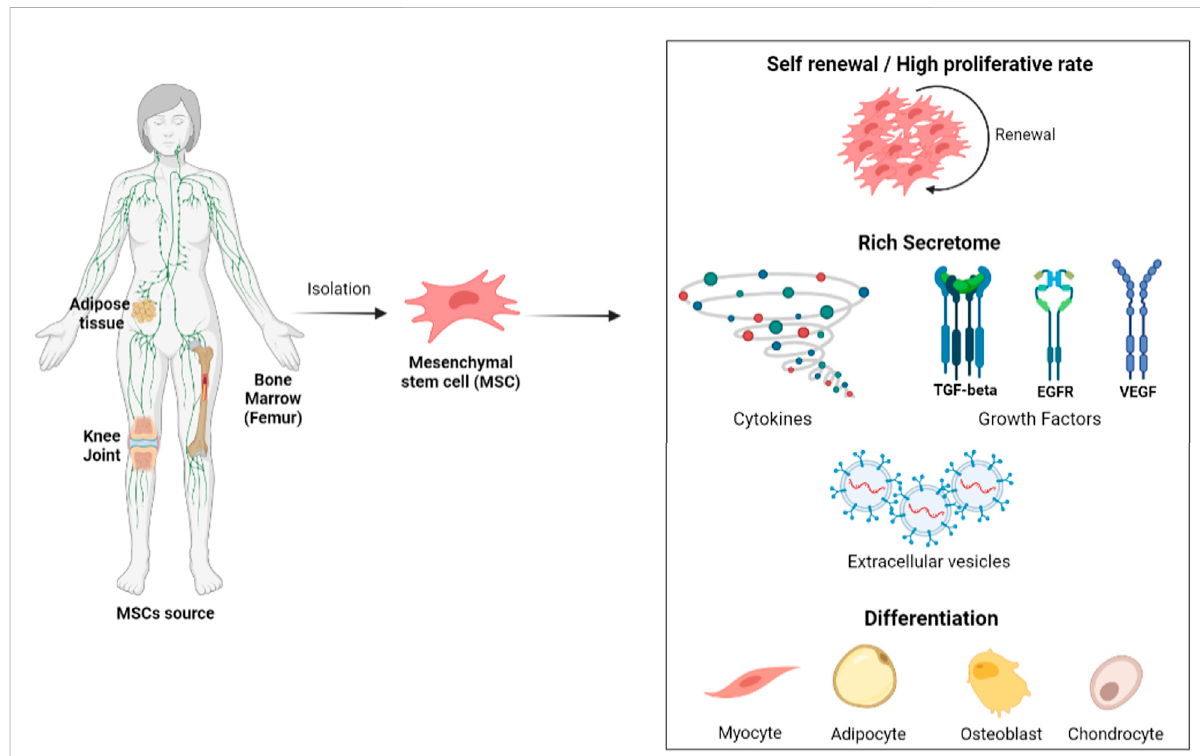
FIGURE 1 Mesenchymal stem cells (MSCs) could be isolated from adipose tissue, bone marrow, and different joints (especially to obtain chondrocytes). Aftertheisolationmethod,theyshouldbeabletodifferentiateintoadipocytes,osteoblasts,andchondrocytes.Severalcharacteristicsdrawattention tostudieswithMSCs, butthemostattractiveistheirself-renewal potential,aswellasothertypesofstemcells, andthepresenceofasecretome with different molecules such as cytokines, growth factors, and extracellular vesicles. Image created on BioRender.